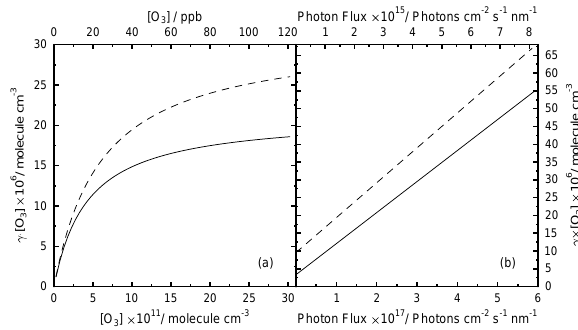
Fig. 9. Oxidative power, γ · [O 3 ], as a function of [O 3 ] (a) and pho- ton flux (b) for the 1:1 by mass PP/NG substrate. Solid and dashed lines represent oxidative power under VIS and UV irradiation, re- spectively. Dashed line in (b) refers to top